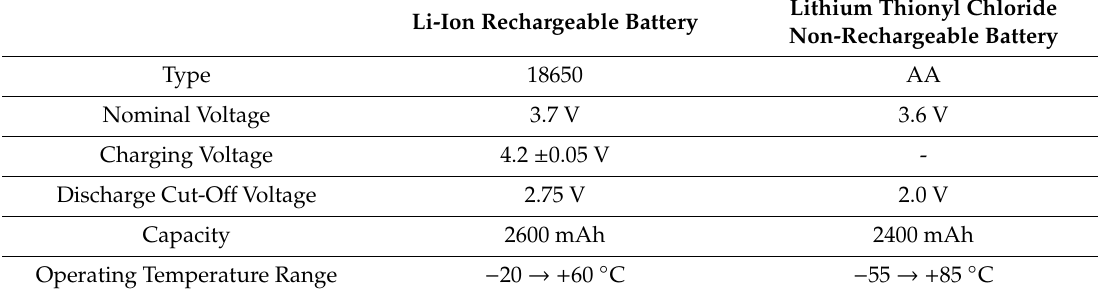
Table 4. Battery specifications.